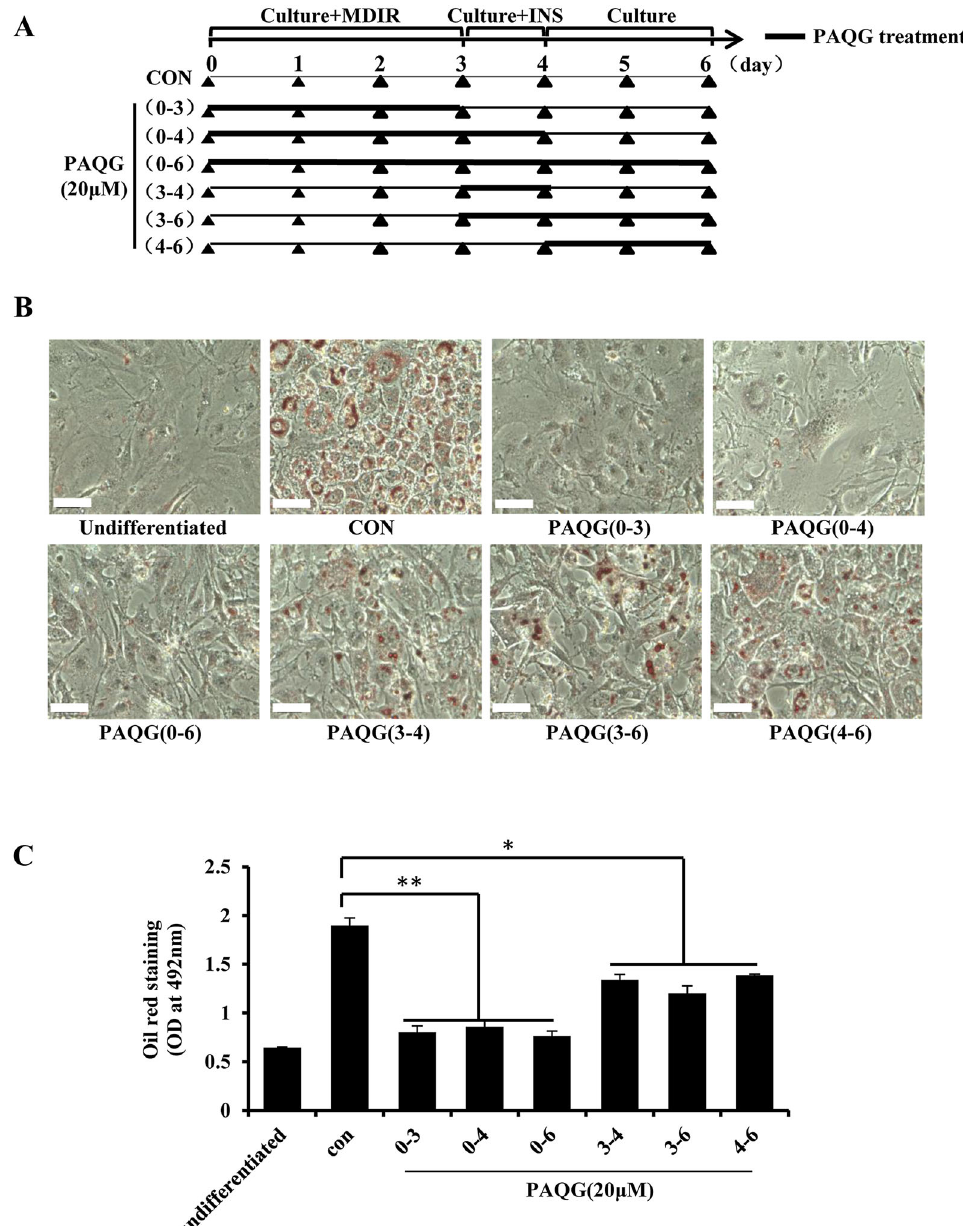
Fig. 2 PAQG suppresses early initiation of adipogenesis. a 3T3-L1 pre-adipocytes were incubated with 20 l M PAQG for the indicated time periods during induction of the adipogenesis. b Oil Red O